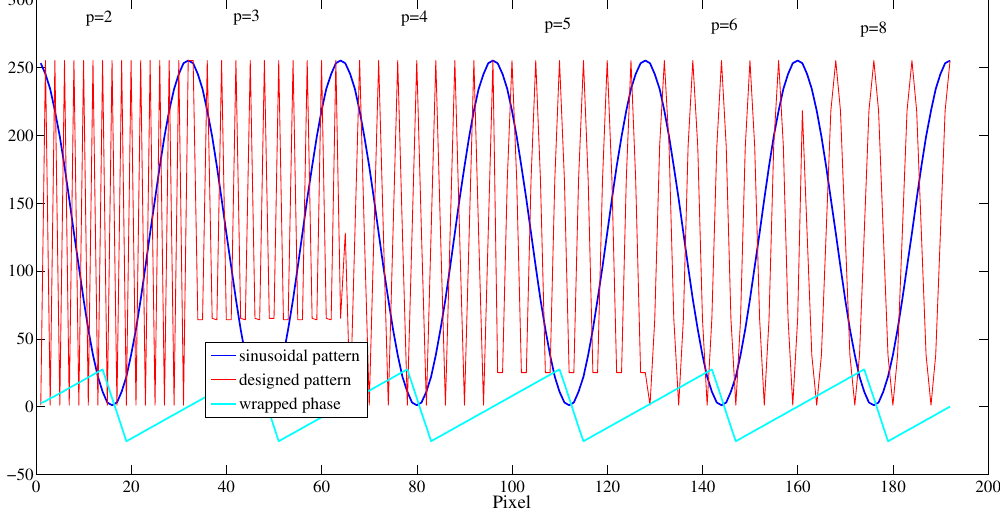
Figure 12. Plot of the sinusoidal fringe pattern with a phase shift of zero that is colored in blue, the phase codeword of the designed fringe pattern that is colored in red, and the wrapped phase that is colored in